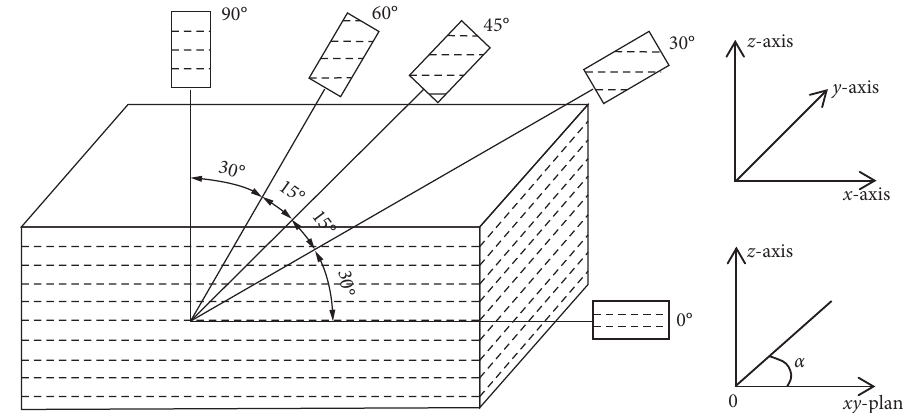
Figure 1: Schematic diagram of the five sampling angles with bedding plane (dip angle a is the inclination angle between the bedding plane and sample drilling direction, which is 0 ° , 30 ° , 45 ° , 60 ° , and 90 ° , respectively).